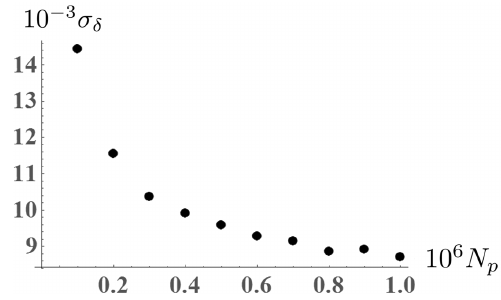
FIG. 29. The final rms energy spread σ δ of CBETA ’ s 4-turn CSR simulation with varying N p . N p ranges from 10 5 to 10 6 at a step of 10 5 , and N b is fixed at